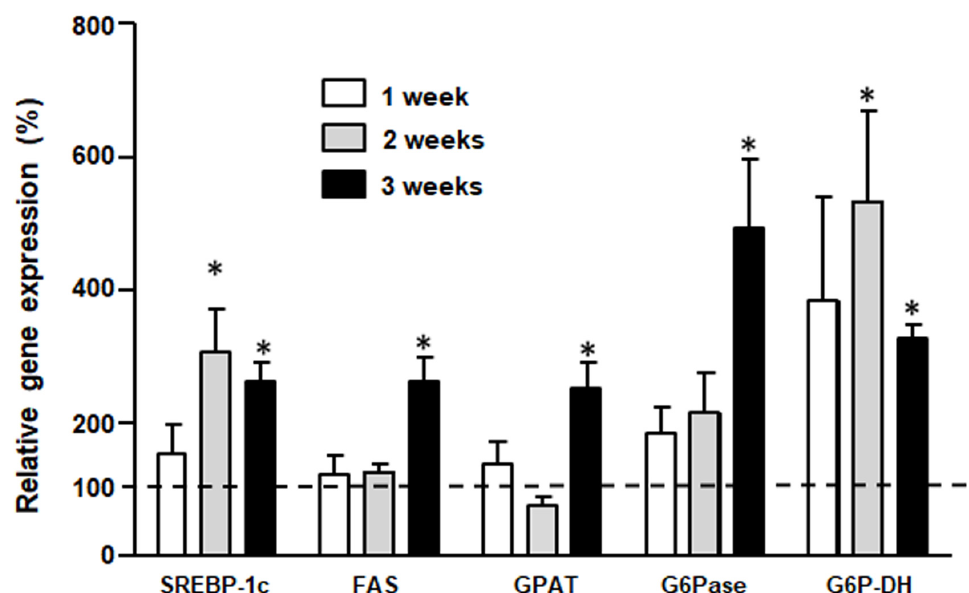
Figure 2. Liver gene expression, lipid and carbohydrate metabolic pathways. Bar plot represents percentage expression of each gene found in F rats compared to the expression (100%) of their respective controls (C rats) (dashed line). Values are expressed as means ± SEM ( n = 12 rats per group) * p < 0.05 compared to each control at each time point.